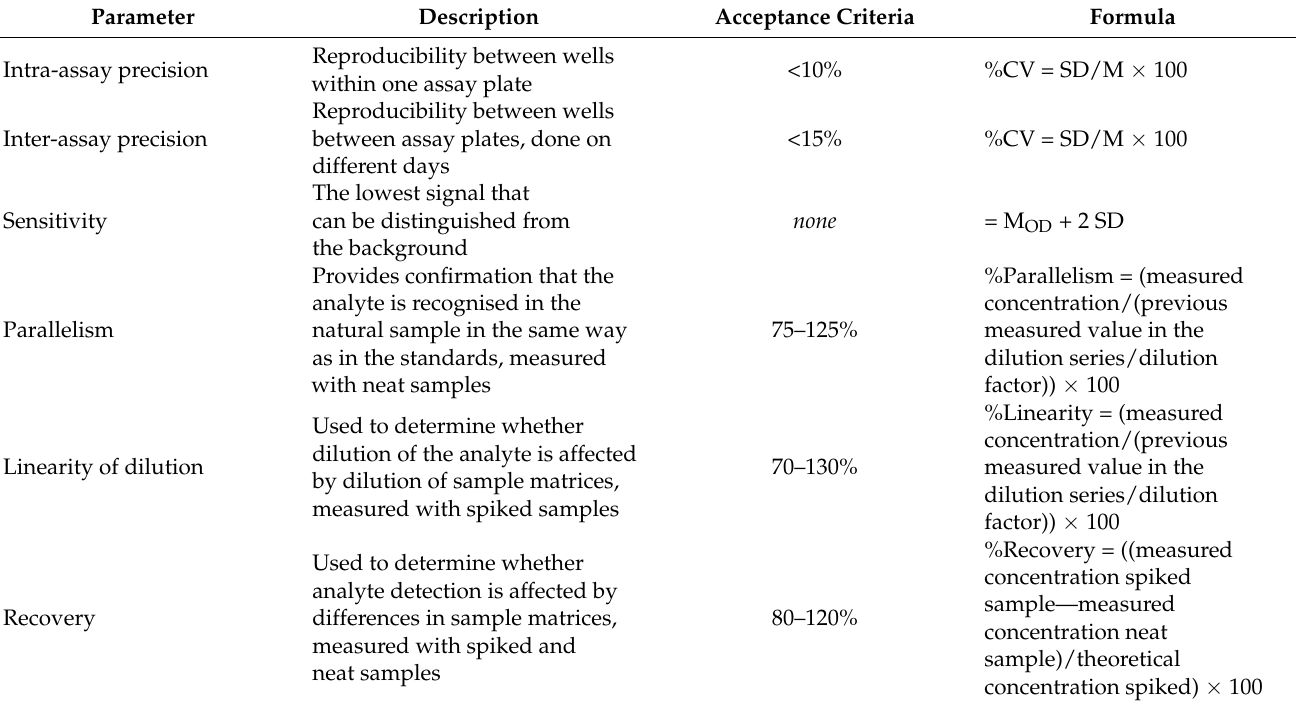
Table 2. Validation parameters of the ELISA